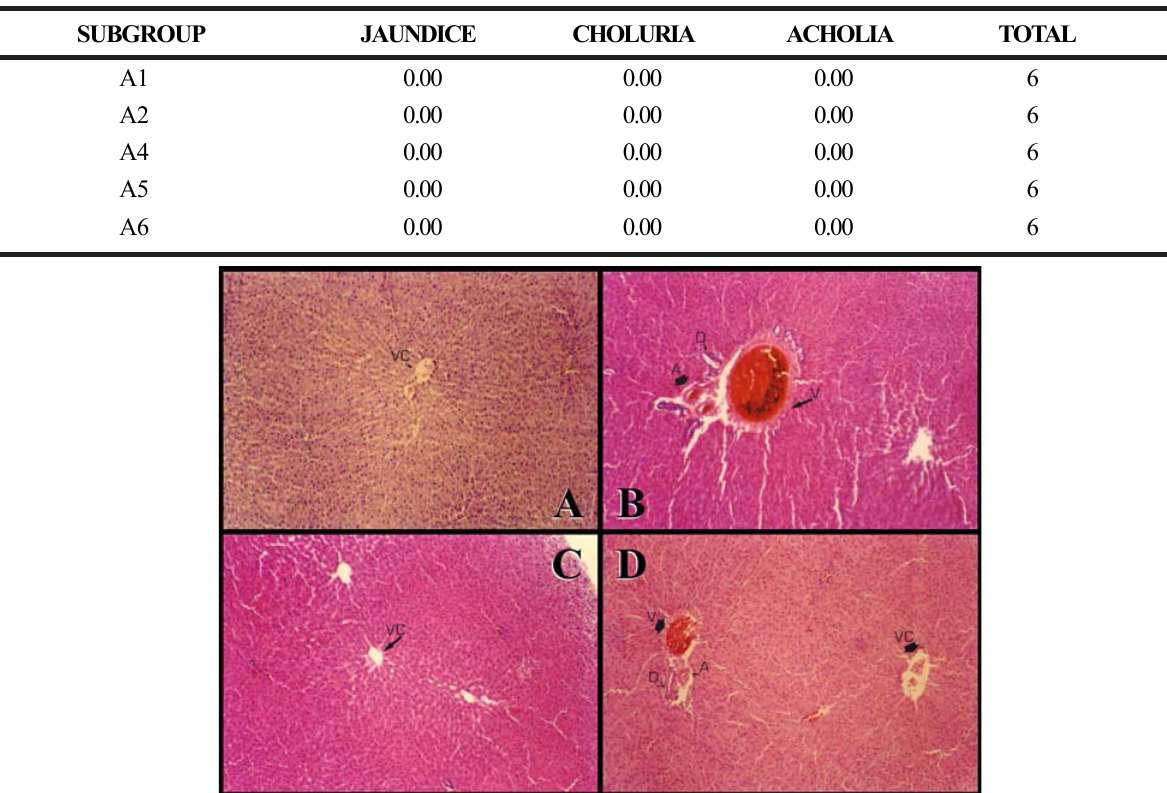
FIGURE 8 - Right lobe (procedure) microphotography of groups (A) A2 (14 days), (B) A3 (21 days), (C) A4 (28 days) and (D) A5 (60 days). (10X HE). It shows centrilobular vein (VC); portal-space (EP); portal-space vein (V); Biliary Duct (D); Artery